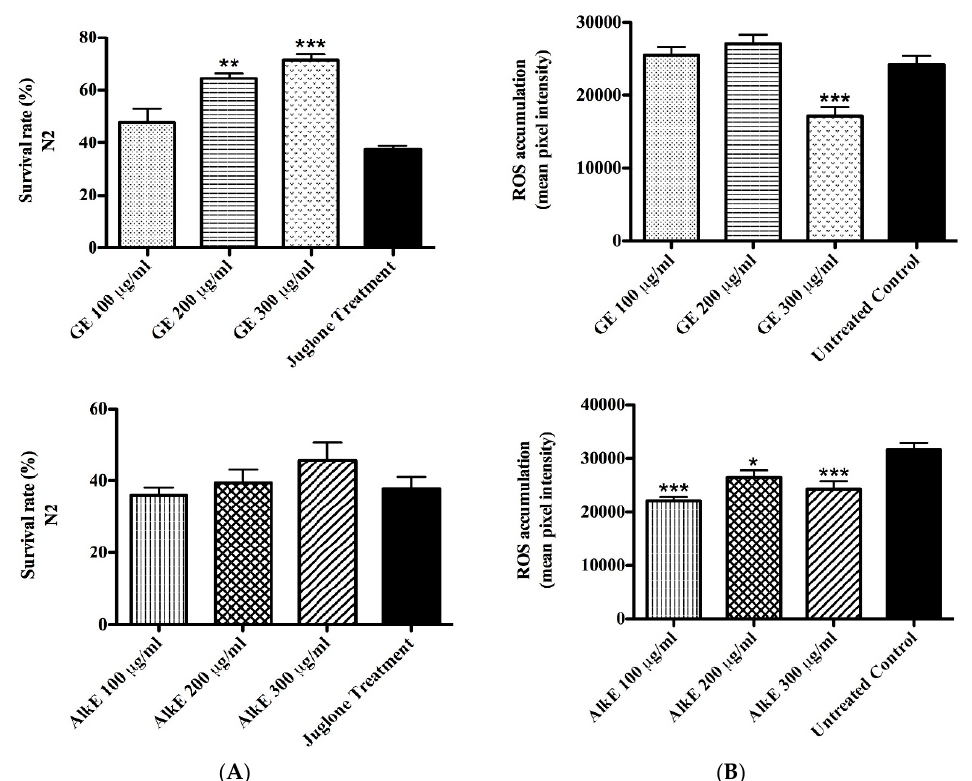
Figure 1. Effect of GE and AlkE on stress resistance of wild ‐ type worms. ( A ) Survival rate of N2 (wt) worms under juglone ‐ induced oxidative stress. Survival rate of N2 worms was significantly enhanced in the groups treated with 200 and 300 μ g/mL of GE; no significant difference was observed among worms treated with AlkE and untreated worms. ( B ) Intracellular reactive oxygen species (ROS) accumulation in N2 (wt) worms after treatment with GE. ROS accumulation was significantly decreased by GE and AlkE treatment compared to the untreated control. The results are presented as mean ± SEM from three independent experiments. * p < 0.05, ** p < 0.01 *** p < 0.0001 compared to the untreated control by one ‐ way analysis of variance (ANOVA) followed by Bonferroni’s method (post ‐ hoc).